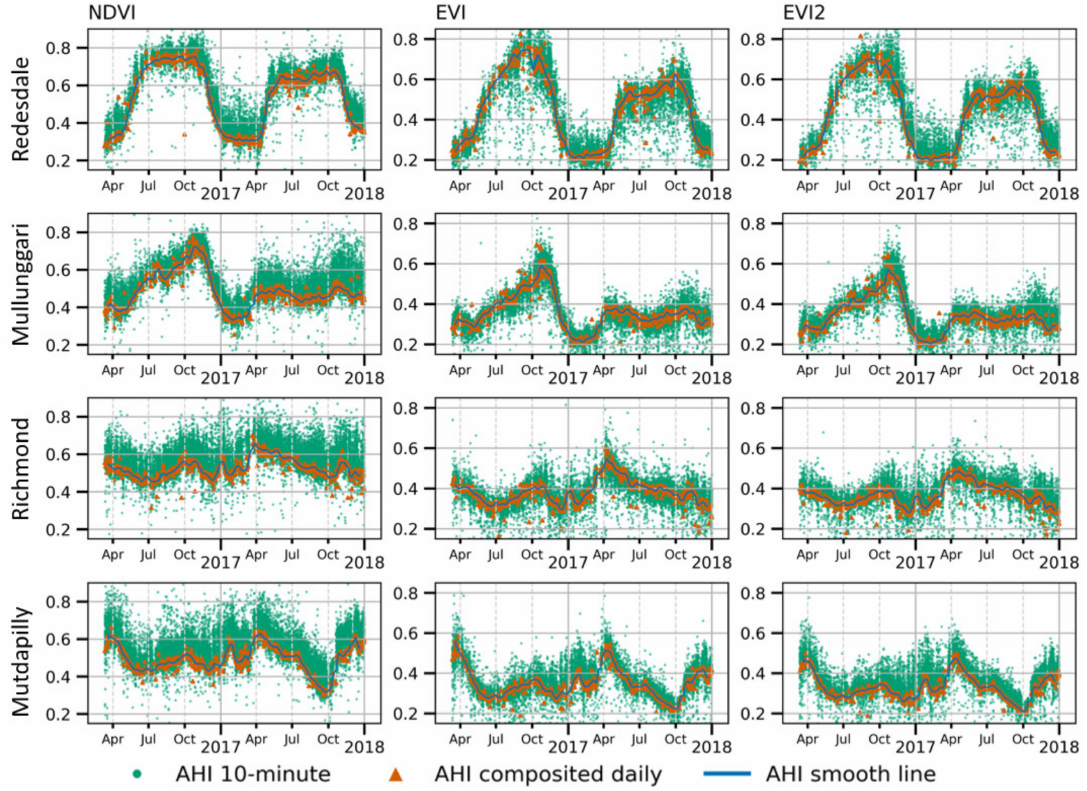
Figure 9. Comparison of grass seasonal NDVI ( left ), EVI ( middle ), and EVI2 ( right ) profiles at the four grassland sites (2016 and 2017), as depicted by AHI 10-minute data (green points), daily composited data (red points), and 3-day smoothed time-series (blue